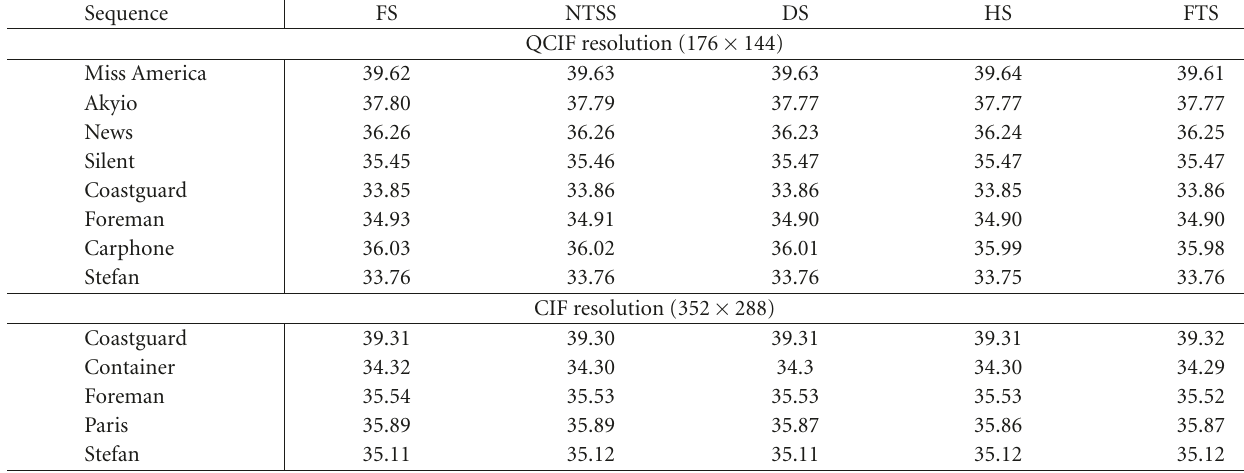
Table 5: Average PSNR (no rate